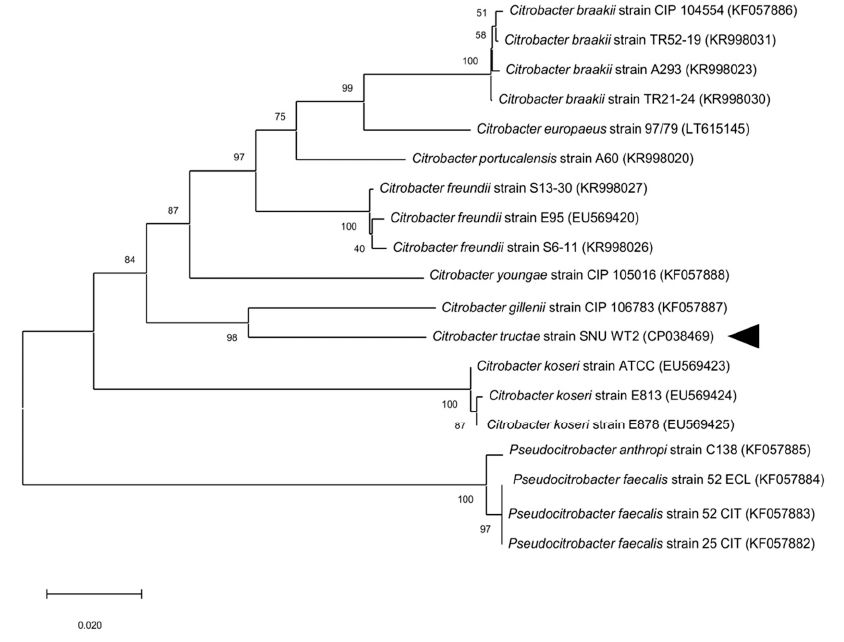
Figure 2. Phylogenetic tree based on the recN gene of Citrobacter species: the neighbor-joining method was used for the tree construction in MEGA 7.0 [28]. The bootstrap values obtained after 1000 replicates are provided at the nodes. Bar, 0.02 changes per nucleotide position. The arrow head indicates SNU WT2.